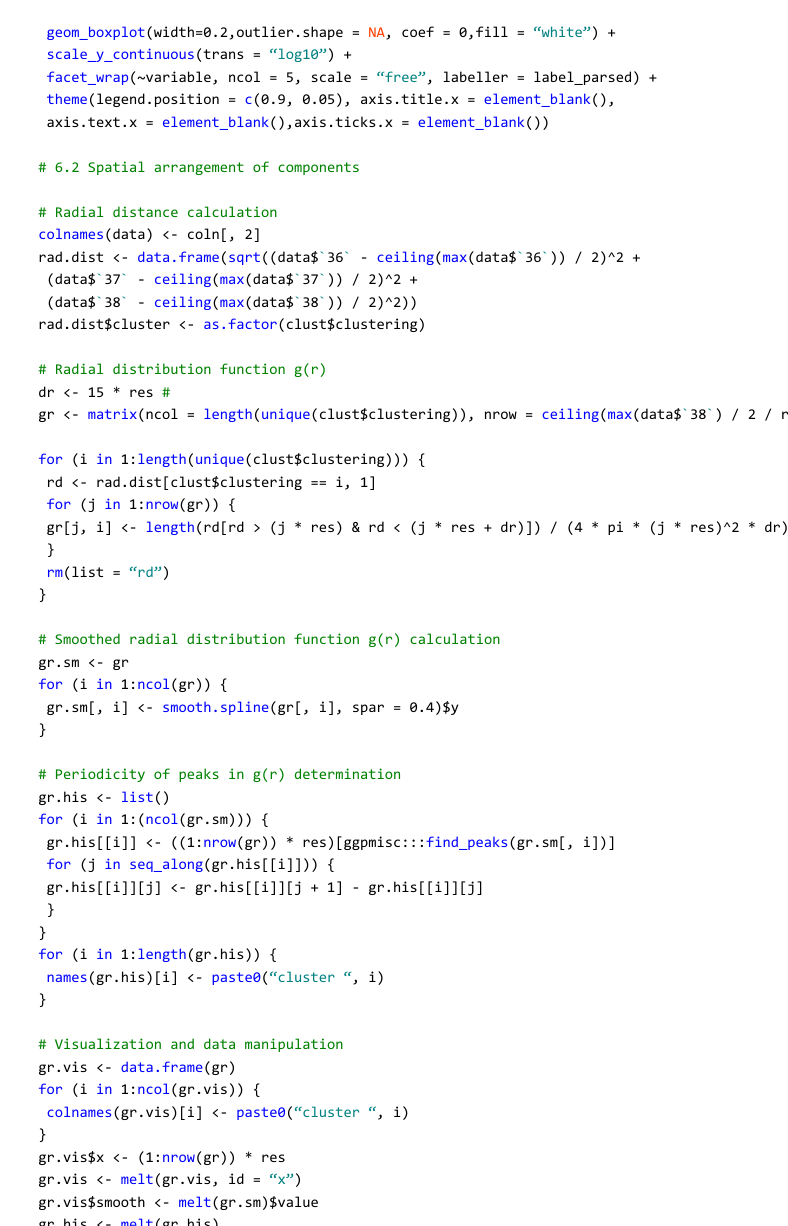
# Figure 11 r1 <- ggplot(gr.vis[gr.vis$x > 0.7, ])